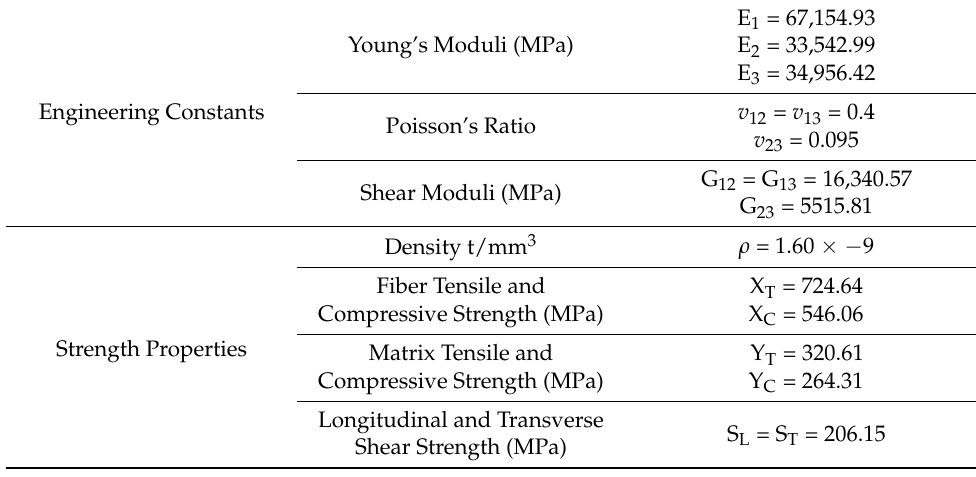
Table 1. Material properties of the composite components of the wing structure.